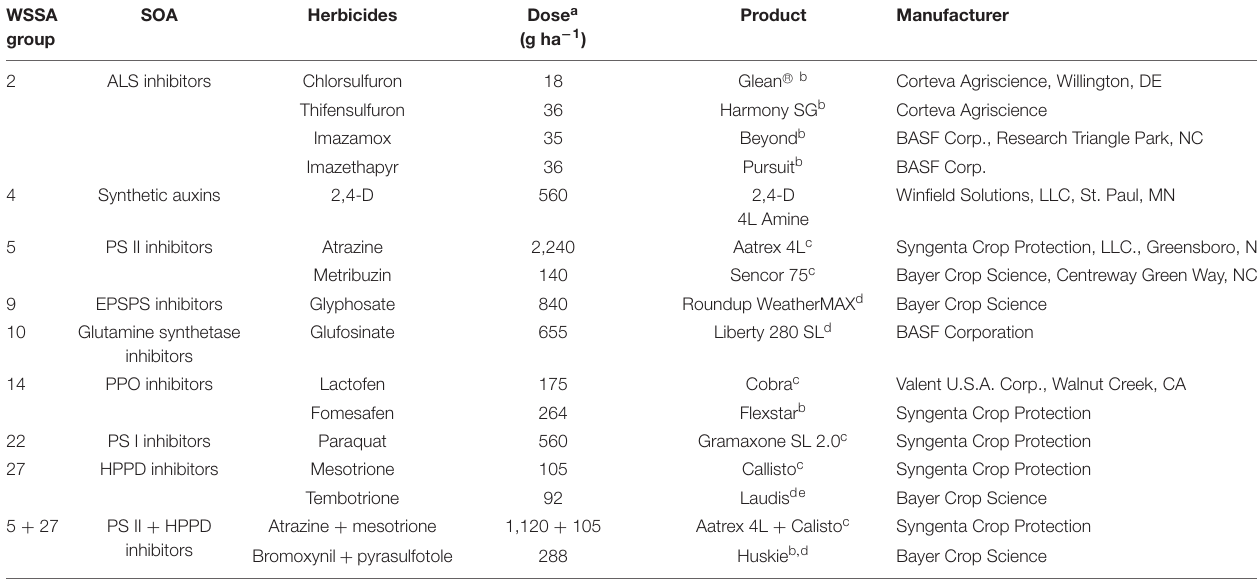
TABLE 1 | POST-emergence herbicide treatments used for screening KCTR, MSS, and KSS Palmer amaranth populations. WSSA group